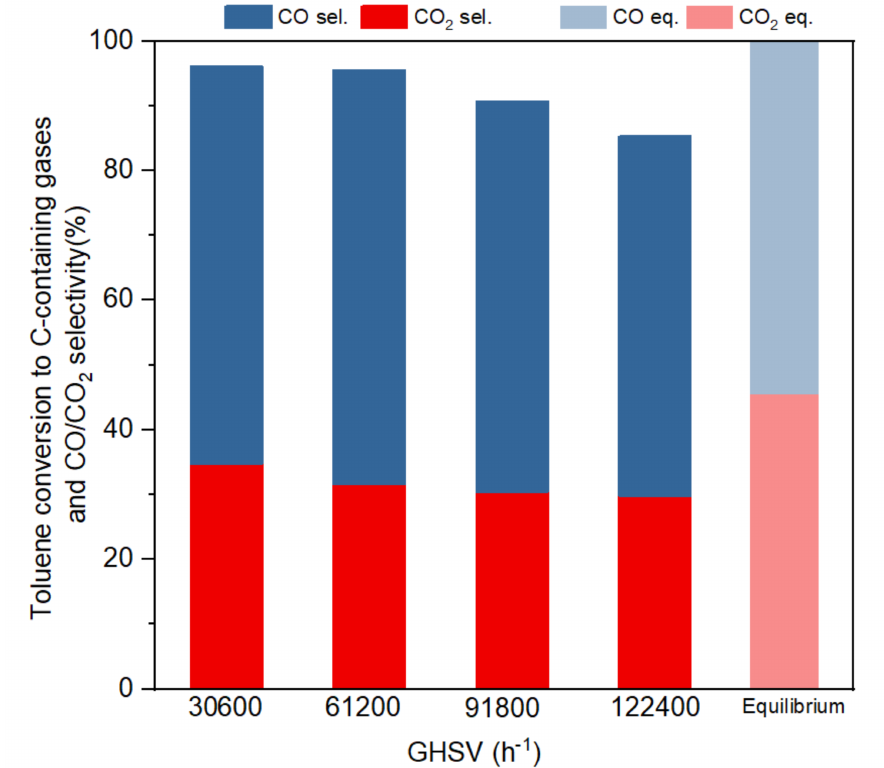
Figure 5. Toluene conversion to C-containing gases and CO / CO 2 selectivity at di ff erent GHSVs (S / C:3, 800 ◦ C).